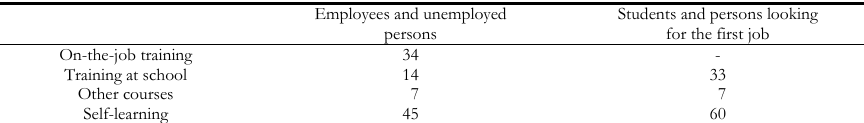
Different ways of learning for one’s own knowledge (average of percentage) Employees and unemployed Students and persons looking persons for the first job On-the-job training